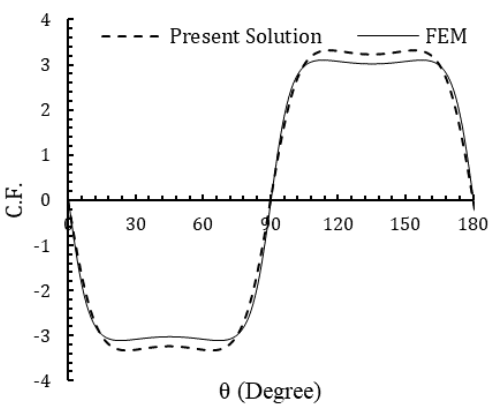
Figure 10. Comparison of stress distribution around square cutout obtained by FEM and present solution (isotropic plate).